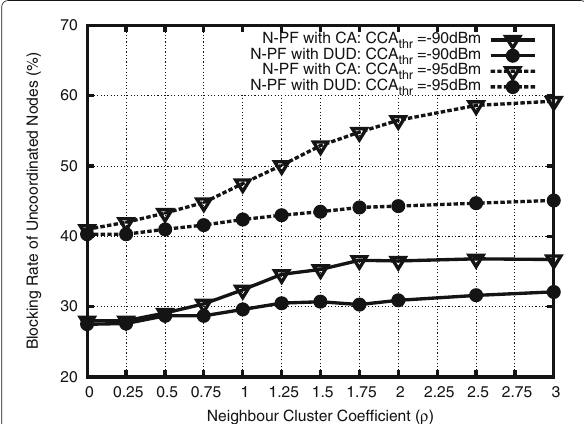
Fig. 8 Packet delivery rate of the scheduled nodes with K = 100, M = 50, and CCA thr = − 85 dBm and different values of BE